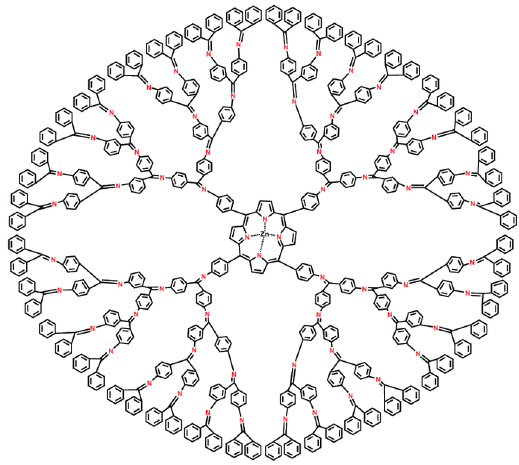
Figure 3. Propyl Ether Imine Dendrimer ( PETIM ) .